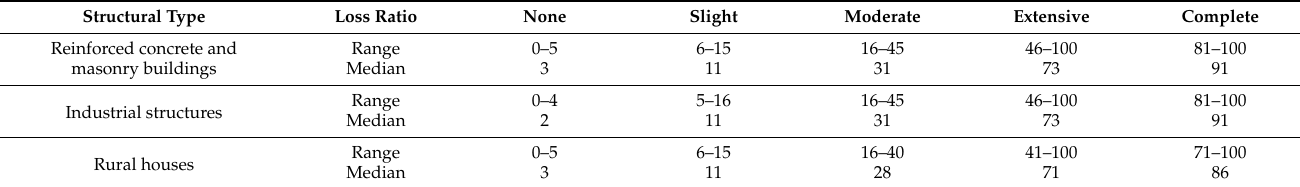
Table 1. Loss ratio of buildings (in percentage)